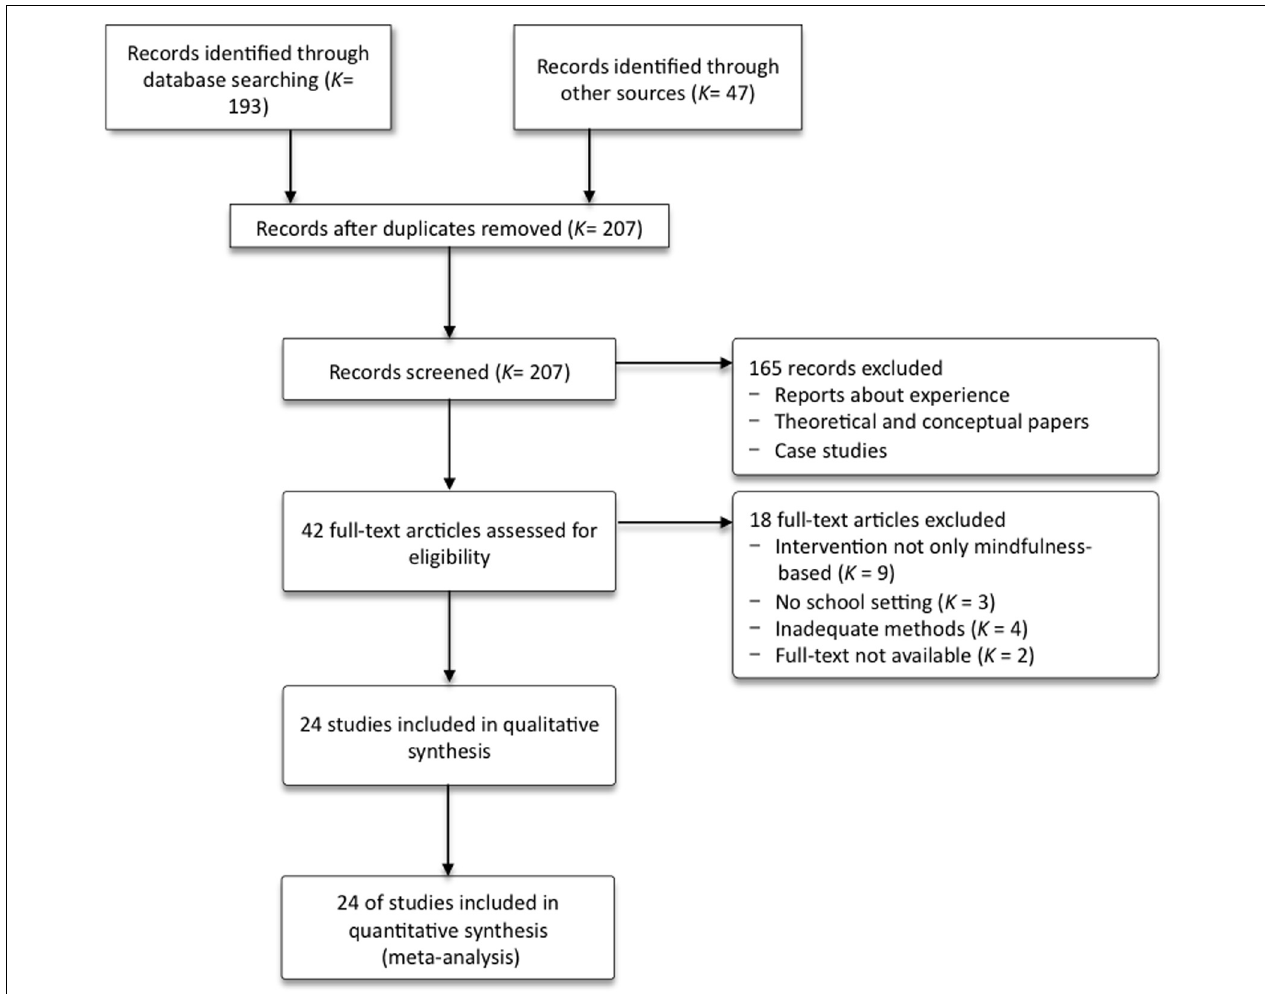
FIGURE 1 | Flow of information from identification to inclusion of